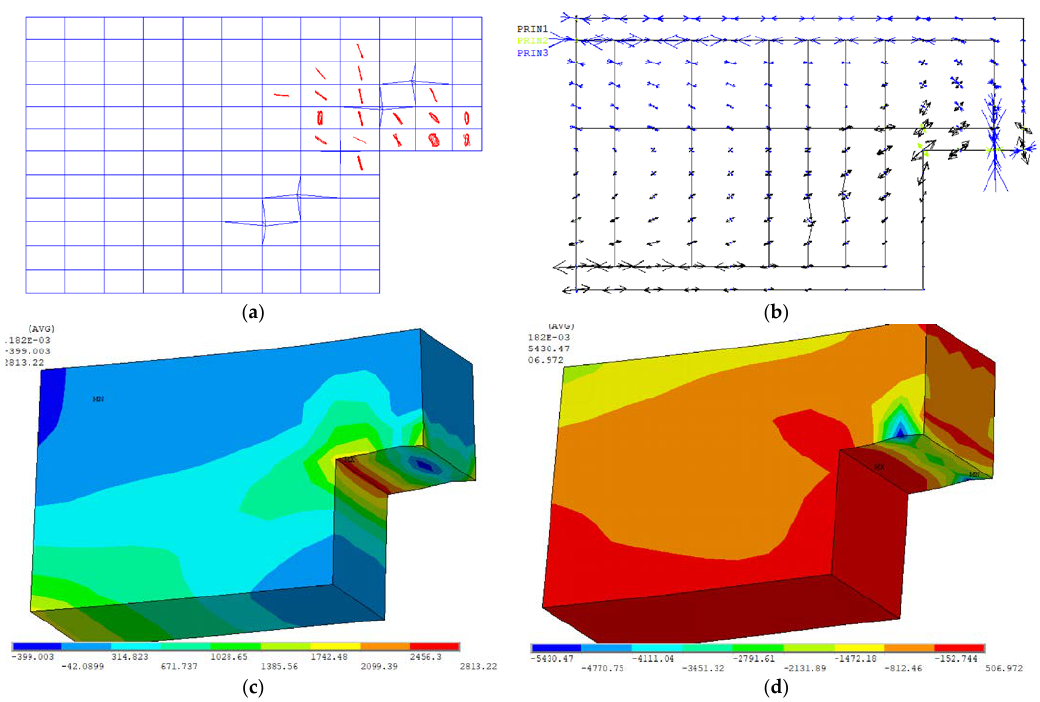
Figure 18. Half-joint in NS-ND configuration. ( a ) Cracking surfaces at collapse (87% final load); ( b ) vector plot of principal stresses just before collapse; ( c ) 1st principal stress just before collapse [kN/m 2 ]; ( d ) 3rd principal stress just before collapse [kN/m 2 ].